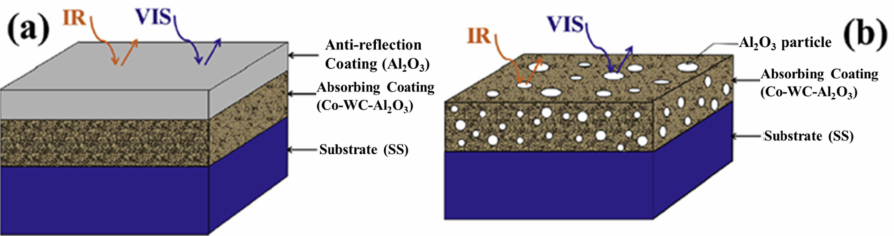
Figure 8. Schematic illustration of Co-WC-Al 2 O 3 metal–dielectric composite solar selective absorbing coating: ( a ) double-layer composite coating; ( b ) single absorbing coating, reproduced from [43], with permission of Elsevier